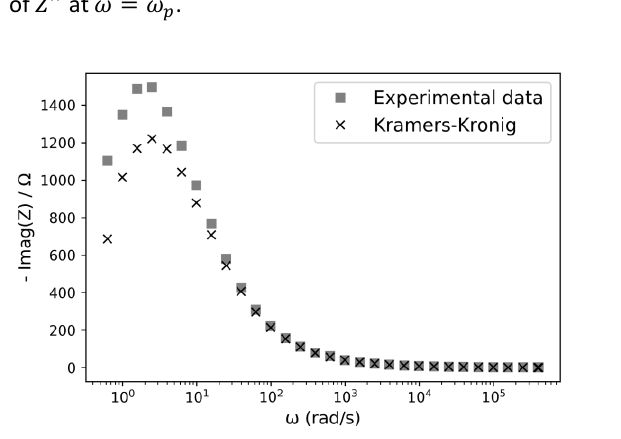
Fig.4: Reactance series equivalent of the ZEEI versus frequency. Experimental data ( ◼ ) and applying the KK equation (4) to the experimental data ( x ).